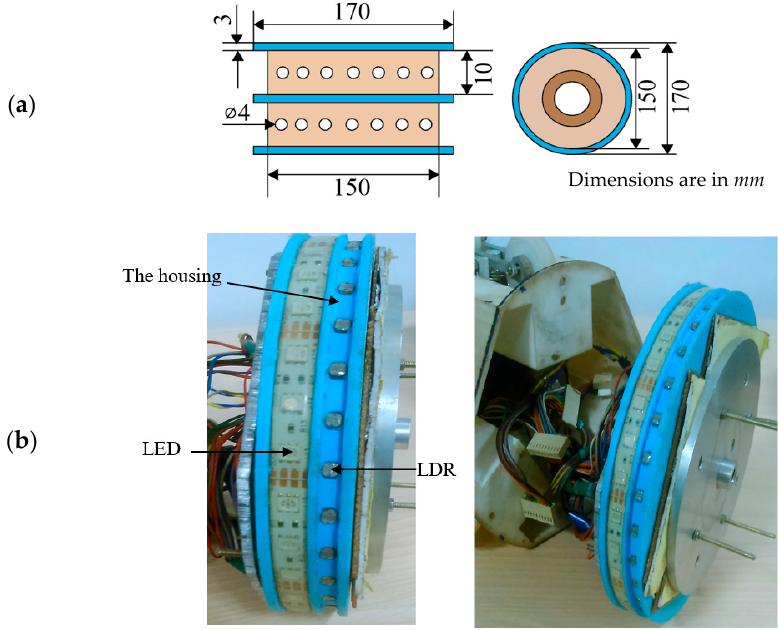
Figure 2. Schematic of the optical sensor array housing system; ( a ) side view and top view of the 2-D optical sensor array system, ( b ) photographs of a side view and the optical sensor array system.